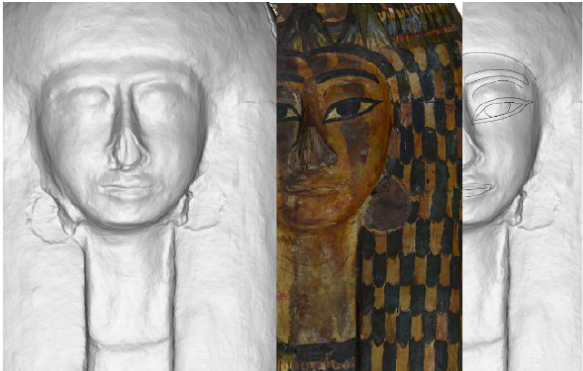
Figure 2. From left to right: greyscale orthophoto, coloured ortophoto, and digitisation of facial features from coloured ortophoto applied onto the greyscale one. Courtesy of the Vatican Coffin Project (©Musei Vaticani).